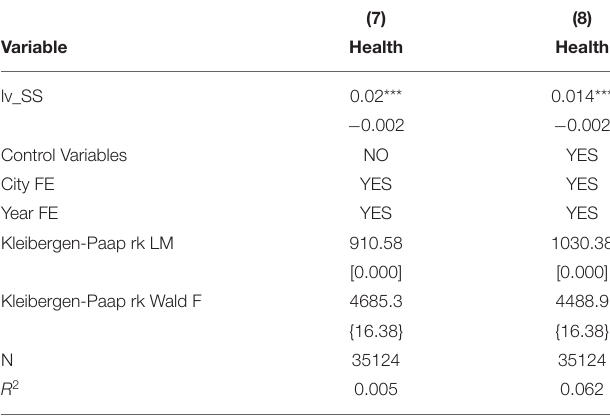
TABLE 5 | The 2SLS regression result of robustness